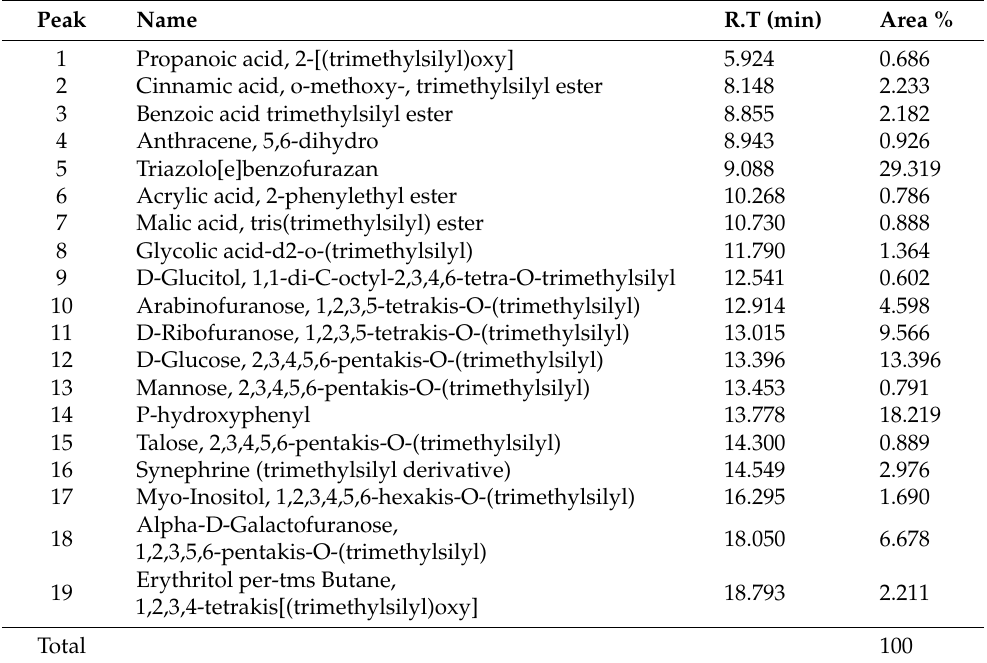
Figure 2. GC-MS chromatogram of the hydro-ethanolic extract of L. officinalis Chaix after silylation. Table 2. Compounds discovered in the L. officinalis Chaix HE extract using GC-MS. Peak